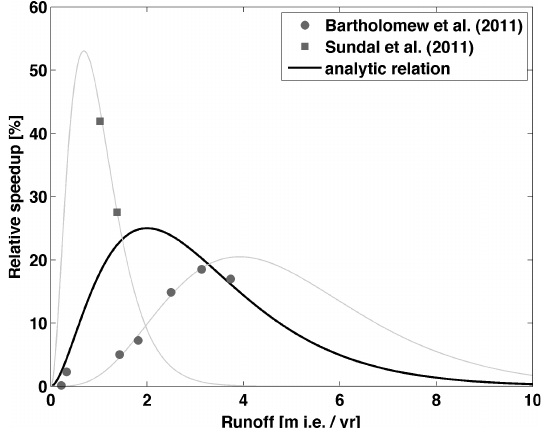
Figure 1. Functional dependence of relative annual speed-up on lo- cal runoff. Dark grey symbols indicate either direct field observa- tions (Bartholomew et al., 2011) or observed speed-up combined with output from a SMB model (Sundal et al., 2011). Observational data originate from Russell Glacier, east of Kangerlussuaq. The pa- rameterisation considers a functional dependence (black line) that is a compromise among all observations. Grey thin lines indicate a best fit to the respective data